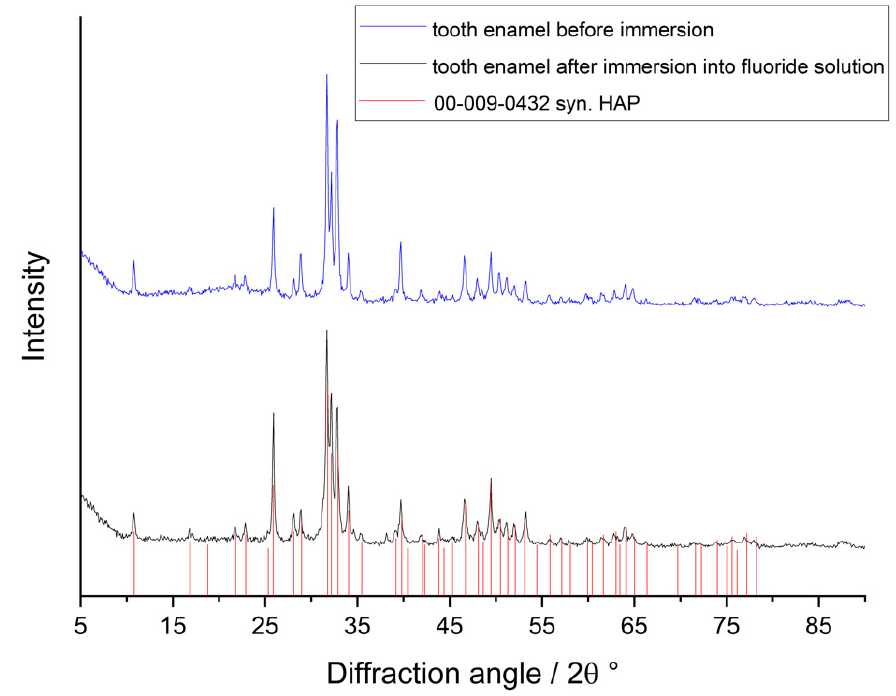
Figure 3. Representative X-ray powder diffractogram of tooth enamel before ( top ) and after immer- sion into 18,998 ppm fluoride solution in citrate buffer (pH 4.7; bottom ). The red bars correspond to synthetic hydroxyapatite (PDF No. 00-009-0432).